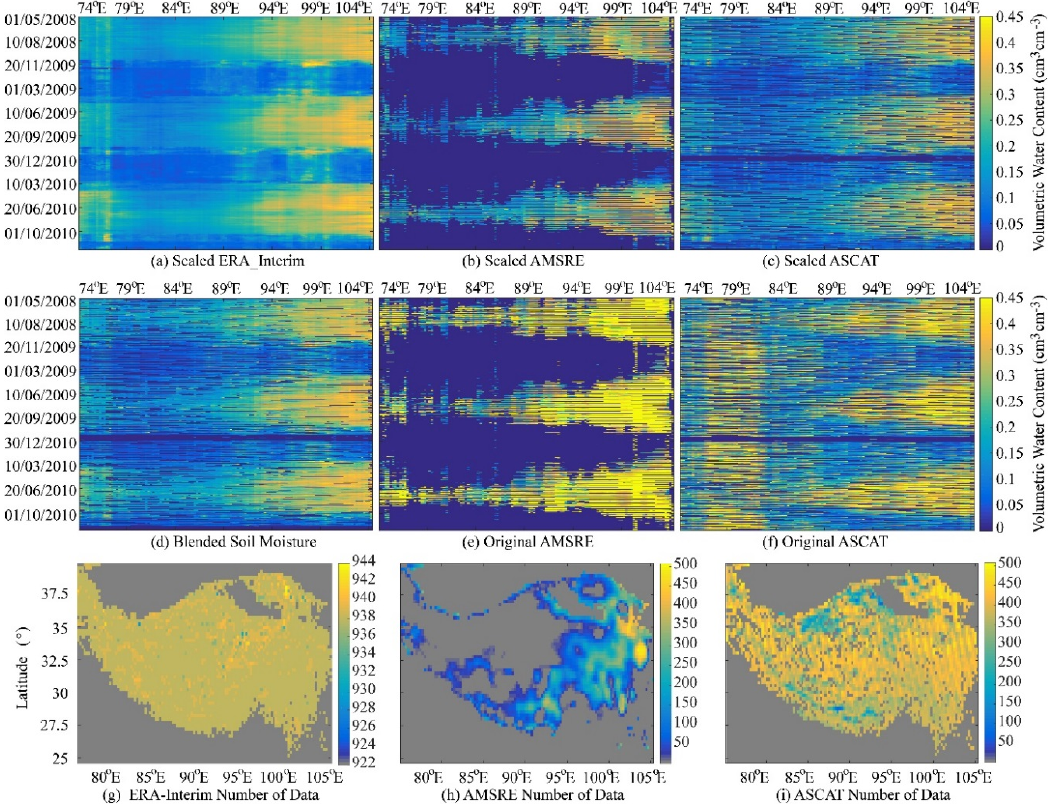
Figure 5. Time-longitude diagram for scaled SM products: ( a ) scaled ERA-Interim; ( b ) scaled AMSRE; ( c ) scaled ASCAT; ( d ) blended SM product; ( e ) original AMSRE; and ( f ) original ASCAT, for the blending period (1 May 2008–31 October 2010); and the number of data for ( g ) ERA-Interim; ( h ) AMSRE; and ( i ) ASCAT.